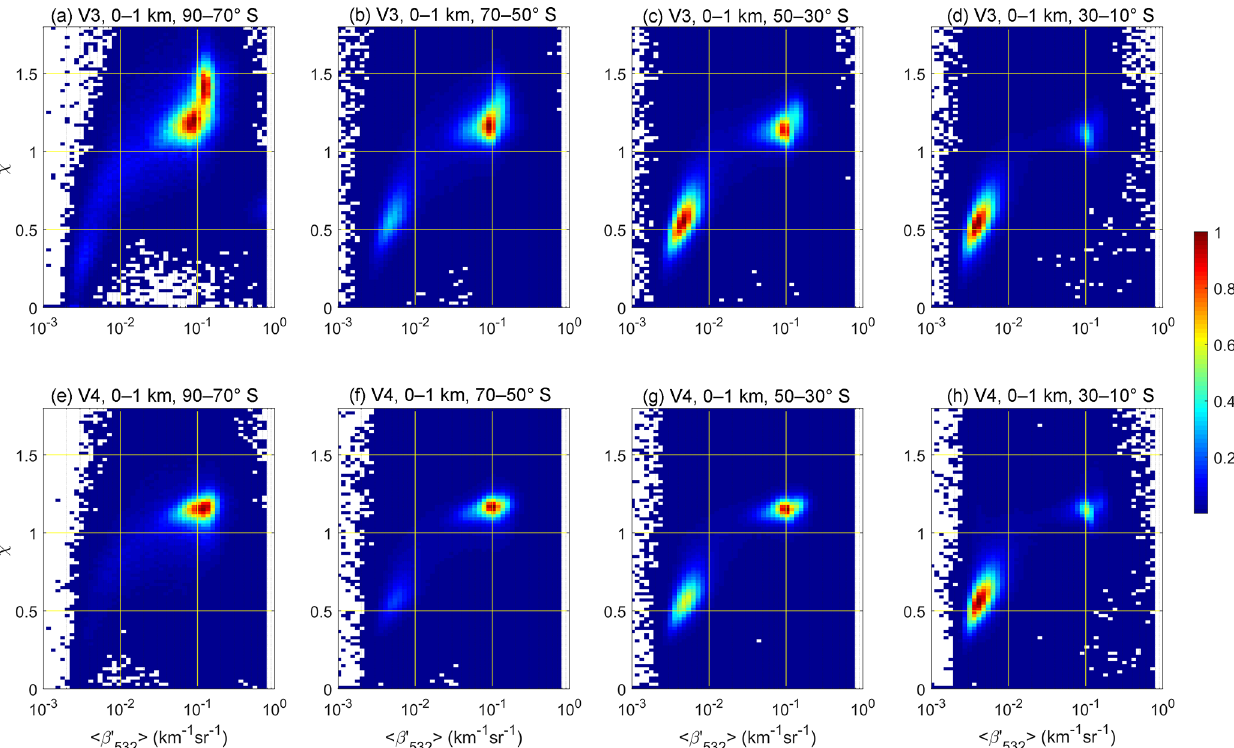
Figure 1. Distributions of occurrence frequency normalized by the maximum occurrence as a function of total color ratio ( χ (cid:48) ) and mean (cid:105) ) for all layers detected at 0–1km altitudes within latitude bands of 90 to 70 ◦ S (a, e) , 70 to 50 ◦ S (b, f) , attenuated backscatter ( (cid:104) β (cid:48) 532 50 to 30 ◦ S (c, g) , and 30 to 10 ◦ S (d, h) , using data from all of 2008 and June 2011. V3 distributions are shown in the upper panels; V4 distributions are shown in the lower